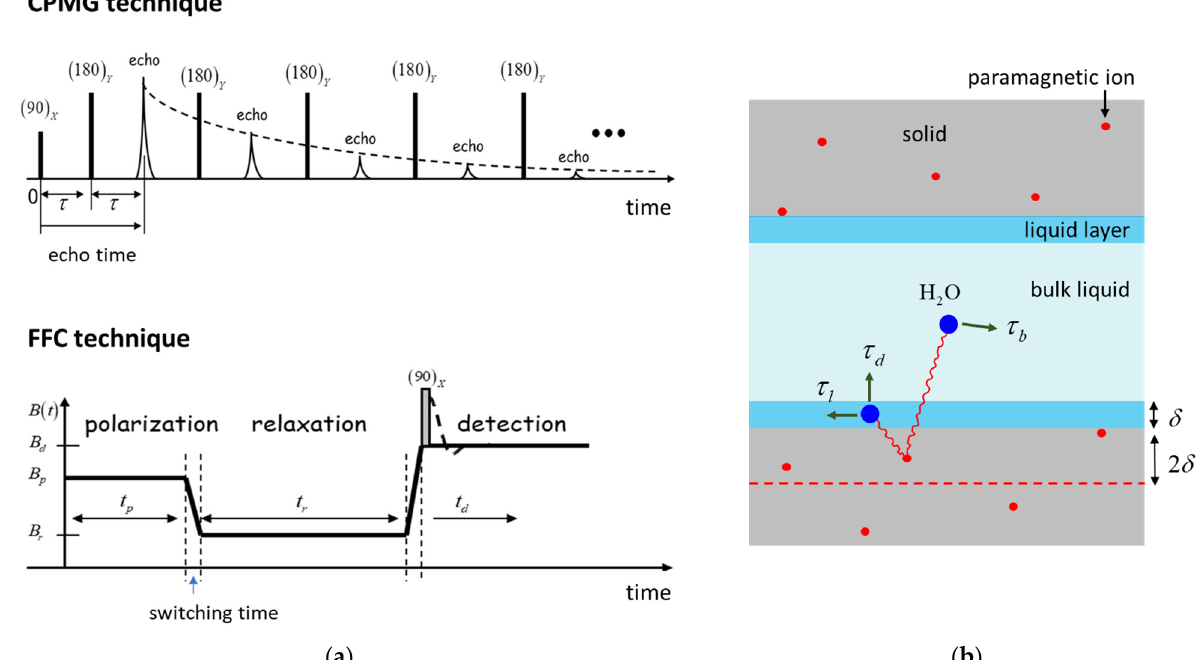
Figure 5. ( a ) Top : CPMG pulse sequence generating the echo trains for transverse relaxation measurements. Bottom: The variation of the main magnetic field along a Fast Field Cycling relaxation experiment. ( b ) The schematic representation of the interactions accounted in the frame of the 3-Tau model [32].